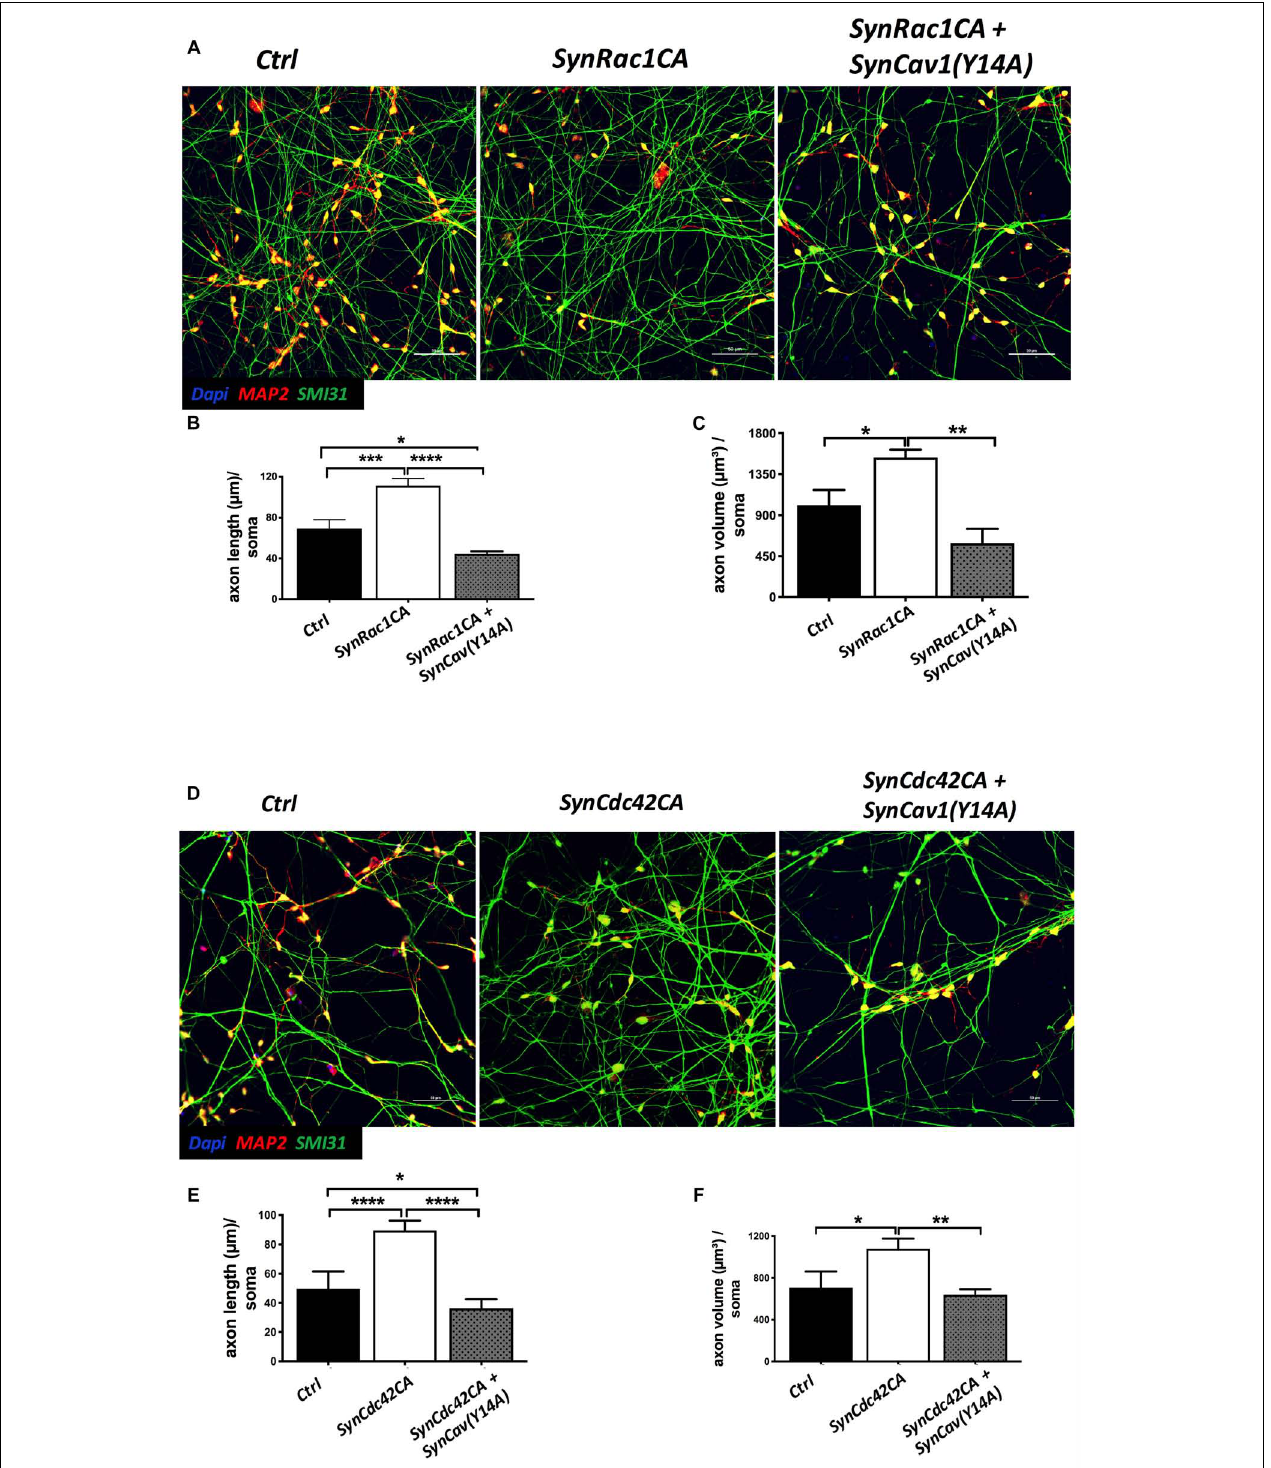
FIGURE 9 | SynCav1(Y14A) suppresses SynRac1CA and SynCdc42CA -mediated axonal growth during NPC differentiation. NPCs were treated with vectors (2 × 10 9 IU/ µ l) as indicated on day 3 and IF was performed on week 2. (A) Representative images of Ctrl , SynRac1CA, or SynRac1CA + SynCav1(Y14A) treated NPCs. Quantitation of axonal length (um) and volume (um 3 ) are shown in (B,C) , respectively. (D) Representative images of Ctrl , SynCdc42CA, or SynCdc42CA plus SynCav1(Y14A) treated NPCs. Quantitation of axonal length (um) and volume (um 3 ) are shown in (E , F) , respectively. NPCs were stained for MAP2 (red), SMI 31 (green) and DAPI (blue). Data are expressed as the mean ± SE ( n = 3, ∗ p < 0.05, ∗∗ p < 0.01, ∗∗∗ p < 0.001, ∗∗∗∗ p < 0.0001, One-way ANOVA).